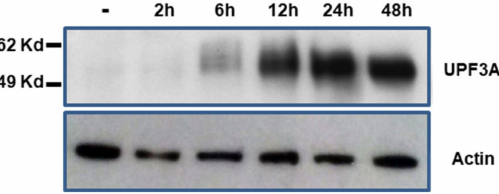
Figure 3. Time course of doxycycline-induced UPF3A protein expression. KM12-UPF3A cells were grown in the absence ( − ) or presence of doxycline (0.5 µ g / mL) for the indicated times and total cellular protein (50 µ g) was analyzed by Western blotting. Human β -actin was used as loading